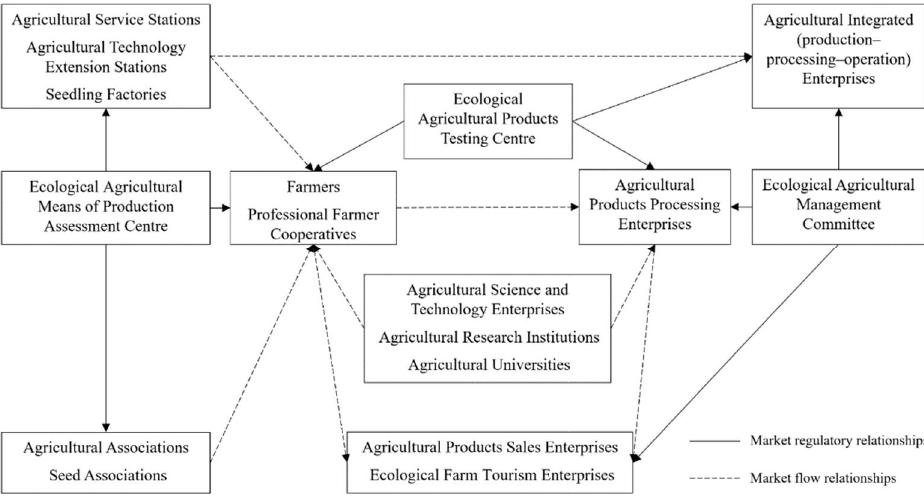
Figure 7. Diagram of the market and regulatory relationships between the various actors in ecological agriculture.